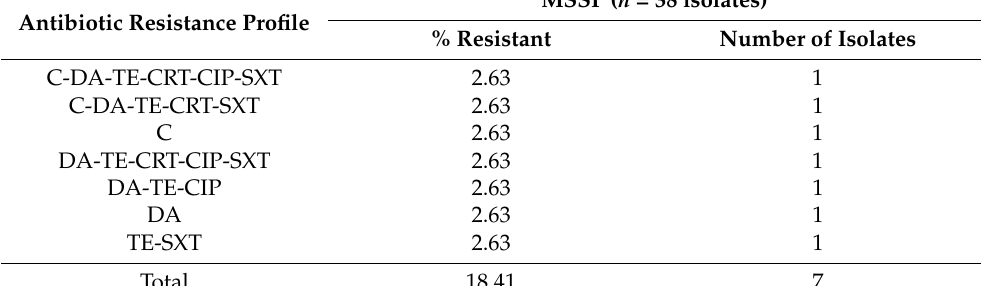
MSSP ( n = 38 isolates) % Resistant Number of Isolates